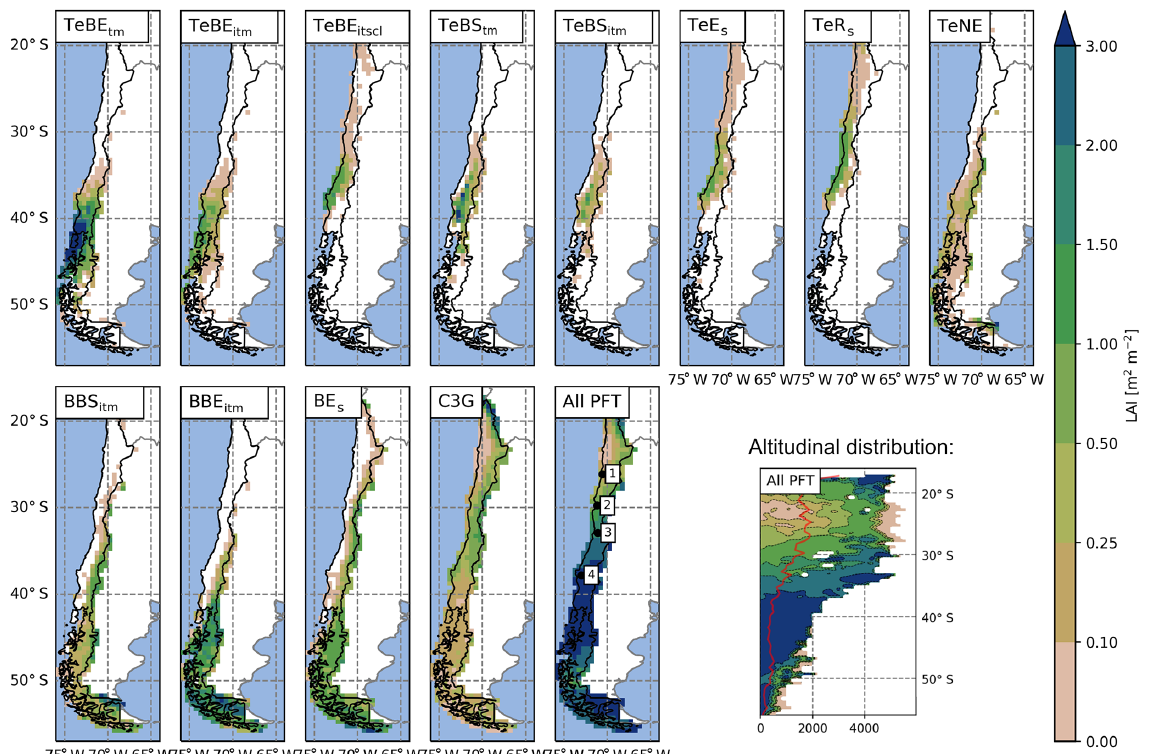
Figure 4. Spatial and altitudinal distribution of modeled plant functional types (PFT) for present-day climate conditions (LAI is the leaf area index – units m 2 m − 2 ; the altitudinal subplot represents zonal mean LAI; the red line represents the average elevation). PFTs are as follows: TeBE tm / TeBE itm (temperate broad-leaved evergreen trees; t is shade-tolerant, it is shade-intolerant, m is mesic), TeBE itscl (tem- perate broad-leaved evergreen trees; scl is sclerophyllous), TeBS im /TeBS itm (temperate broad-leaved summergreen trees), TeE s (temperate evergreen shrubs; s is shrub), TeR s (temperate raingreen shrubs), TeNE (temperate needle-leaved evergreen trees), BBS itm (boreal broad- leaved summergreen trees), BBE itm : (boreal broad-leaved evergreen trees), BE s (boreal evergreen shrubs), C3G (herbaceous vegetation). The number 1 represents Pan de Azúcar, 2 represents Sta. Gracia, 3 represents La Campana, and 4 represents